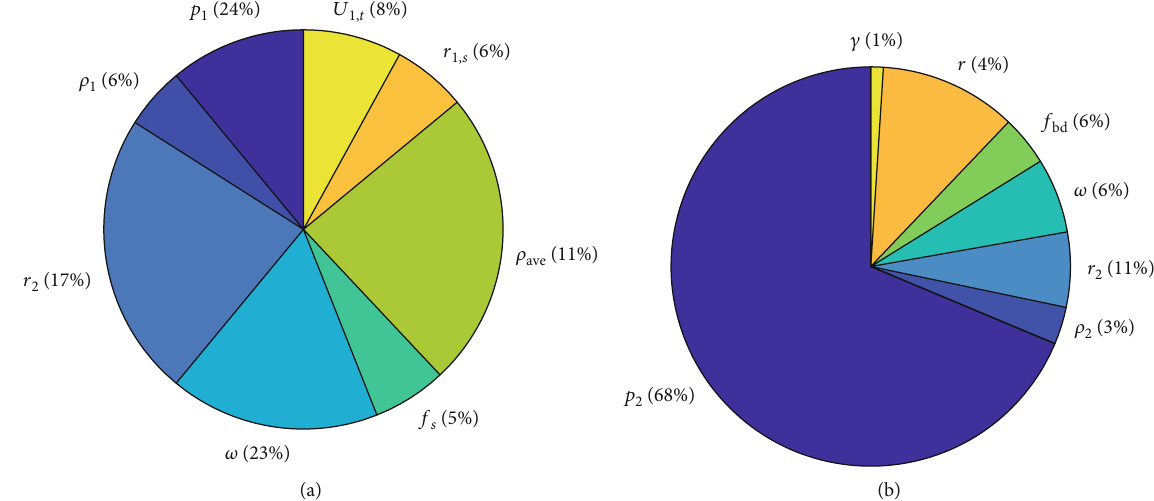
Figure 14: (a) The e ff ect of the parameters on the pressure distribution on the shroud side when predicted by using the new hybrid method. (b) The e ff ect of the parameters on the pressure distribution on the back disk side when predicted by using the new hybrid method.